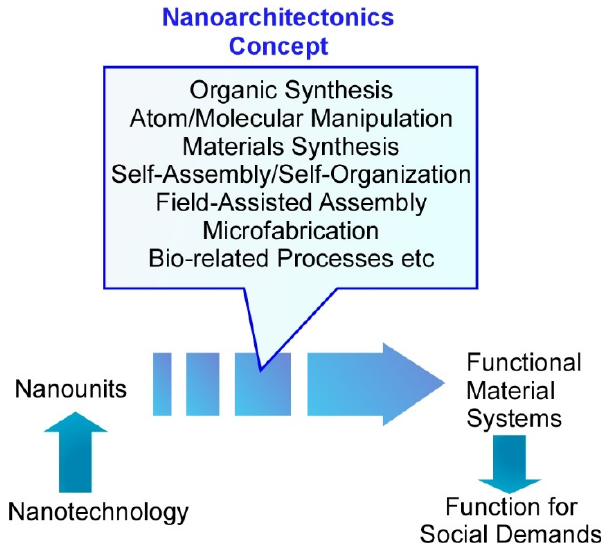
Figure 1. The nanoarchitectonics methodology to produce functional materials and functional structures from nanoscale unit components.